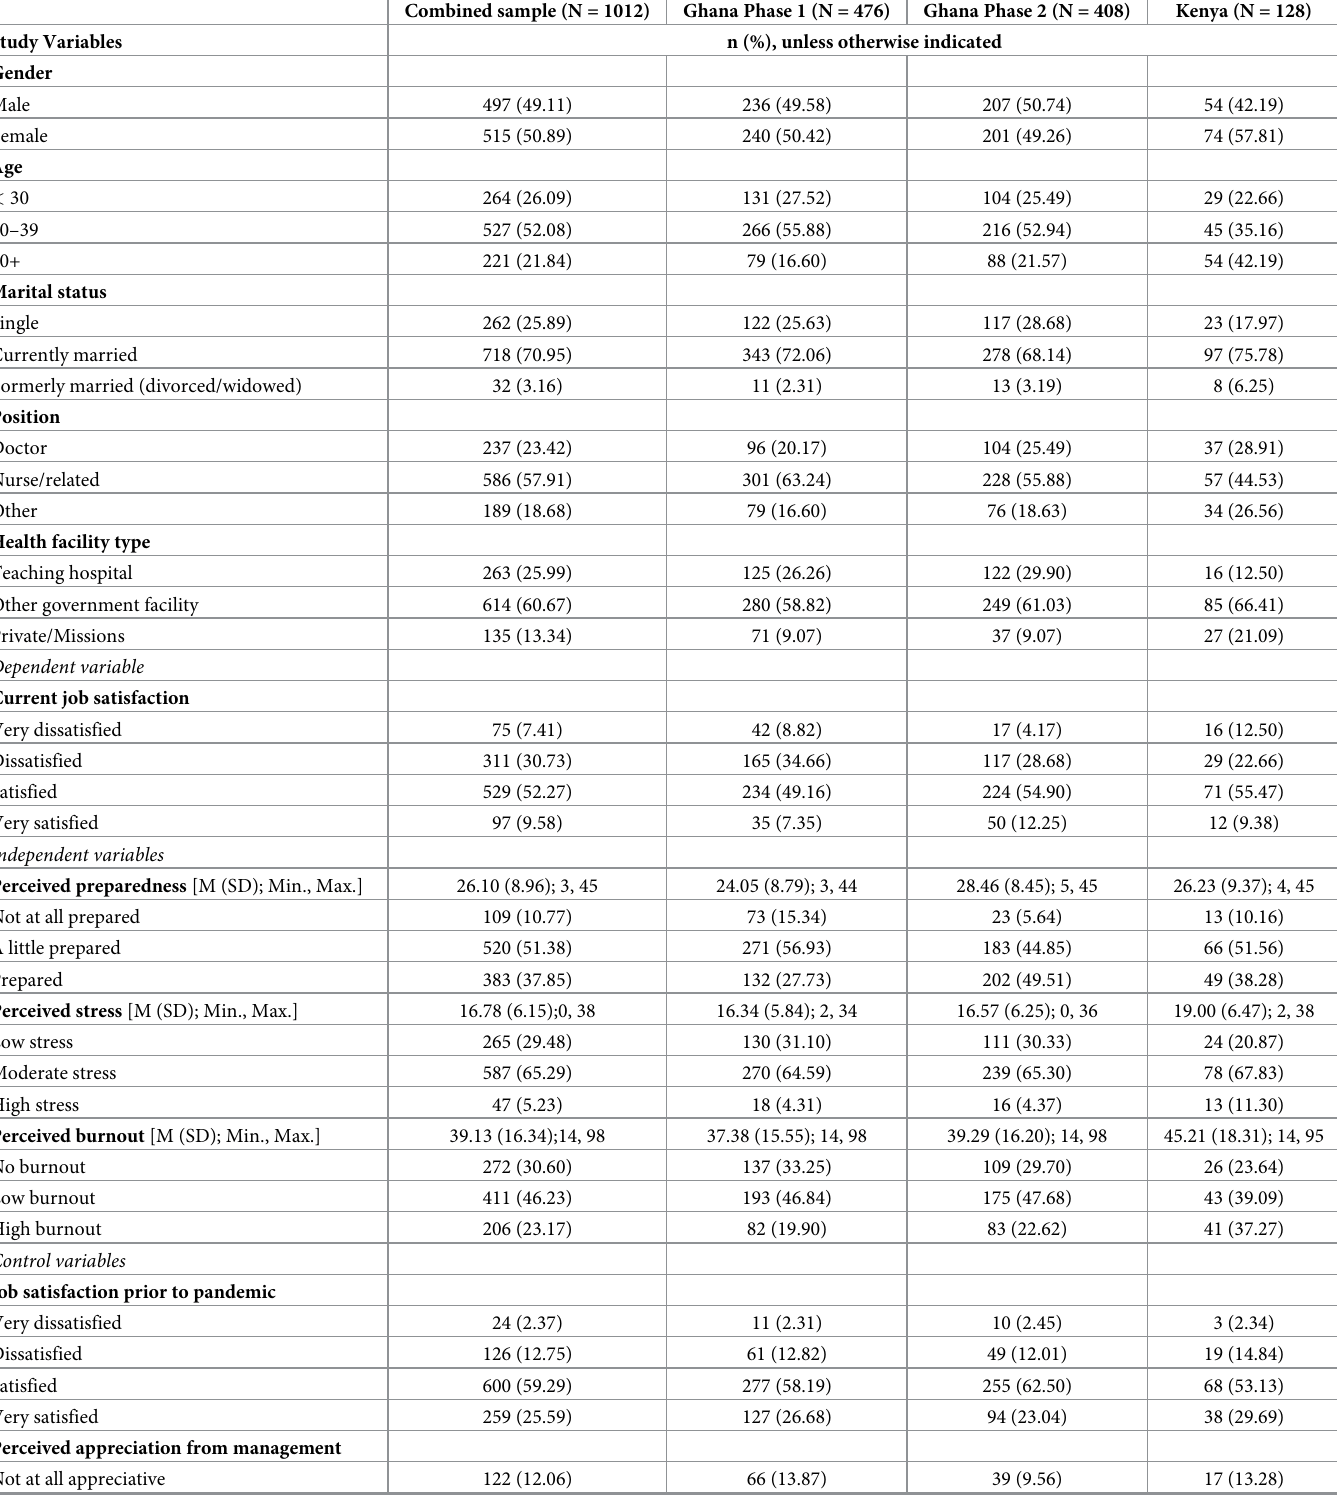
Table 1. Summary statistics of study